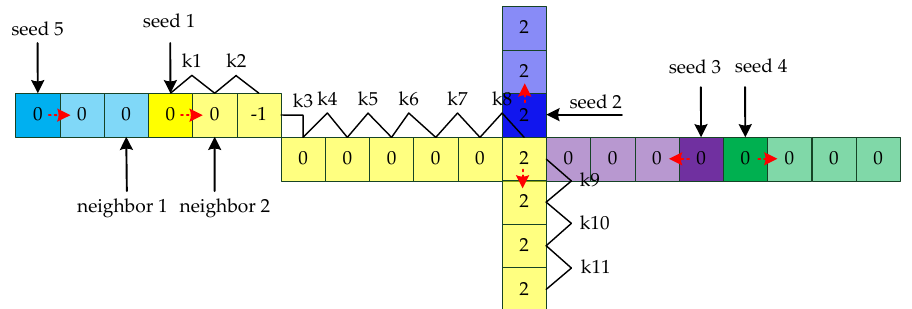
Figure 13. The process of calculating the slope. First, seed 1 is randomly selected in the image. Seed 1 has multiple nearest neighbor points and picks one at random to calculate the slope value 0. The values of seed 1 and neighbor 2 are 0. Then, neighbor 2 is the next seed 1. The points for which the slope has been calculated are not searched later. Seed 1 stops growing if the current point has no neighbors. Then, seed n is randomly selected and the same growth process is carried out until all the pixels of the image are calculated. After calculating the slope at all points, we need to eliminate the fault in the line, as shown in Figure 14. For each point, if it only has two neighbors and the two neighbors have the same slope k , update the slope of that point to k .